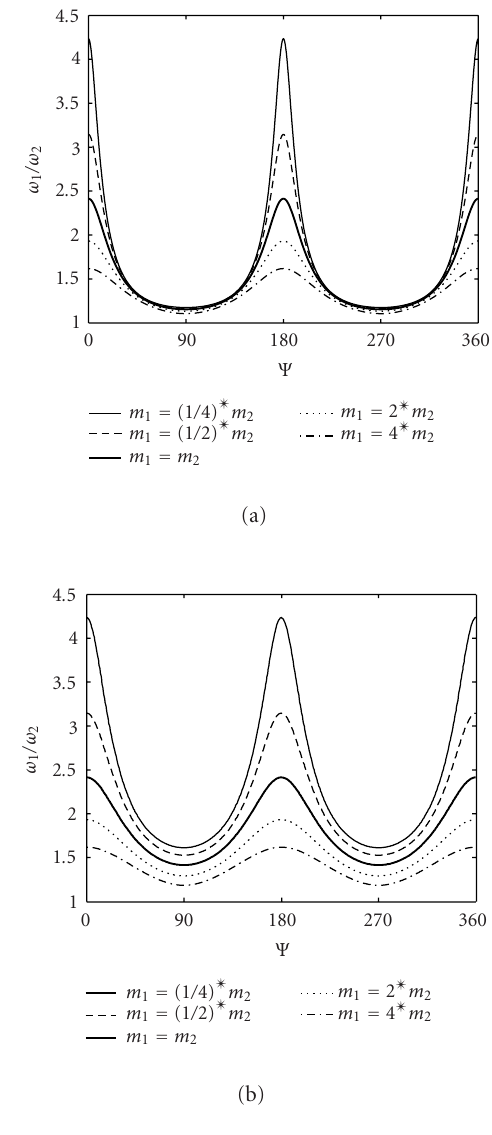
Figure 4.4. Ratio of frequencies versus angle between the oscillation planes for point masses ratio and equal length of pendulums. The initial parameters for (a) L 1 = L 2 = 0 . 2 m, m 2 = 2kg; and for (b) L 1 = L 2 = 1m, m 2 =